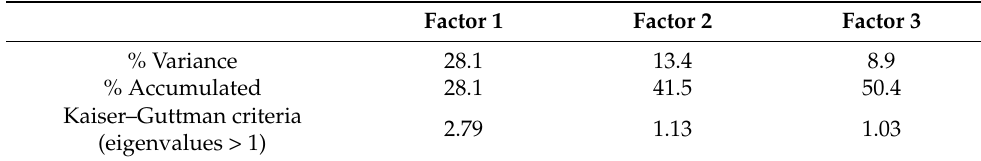
Table 2. Variance explained according to factors and Kaiser–Guttman criteria.